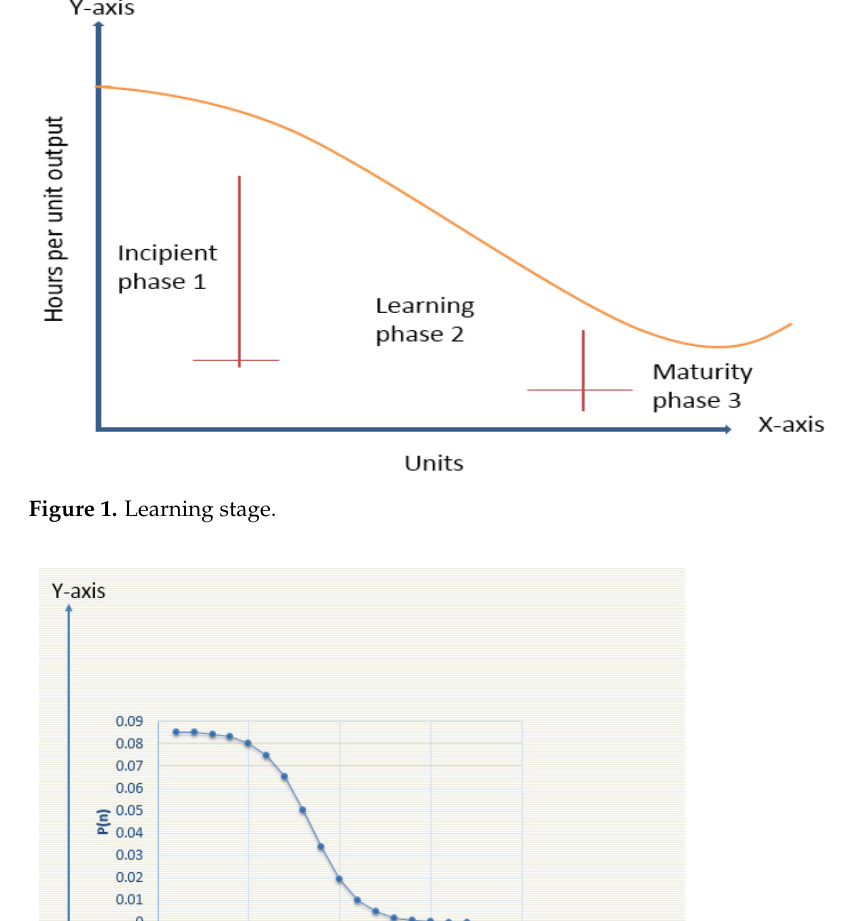
Figure 1. Learning stage.